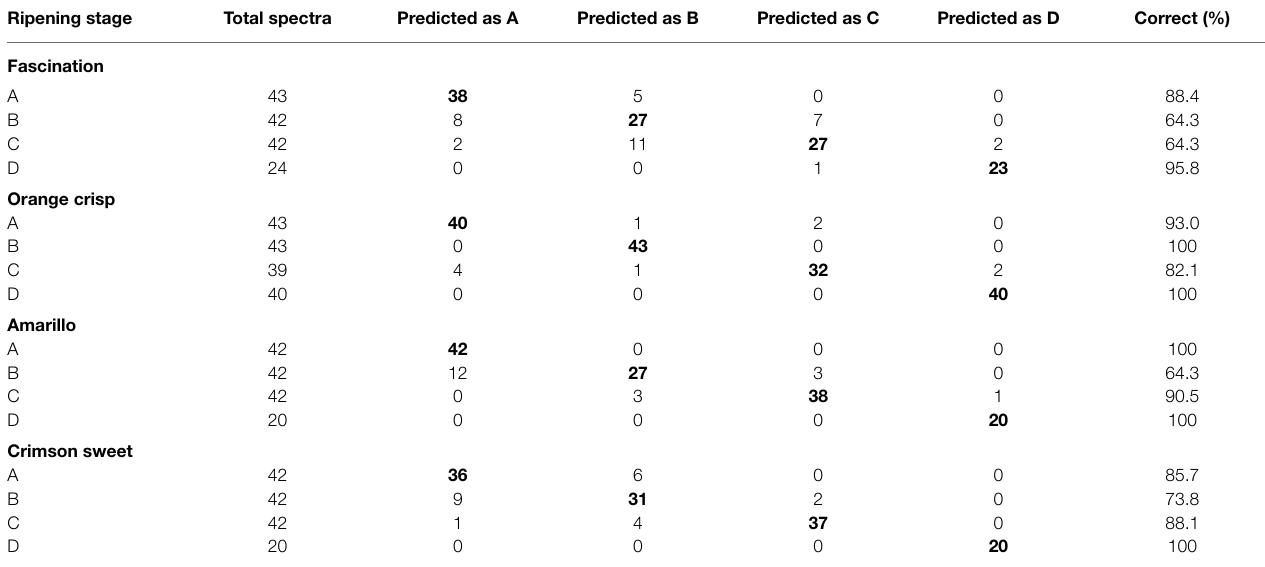
TABLE 1 | Confusion matrix computed from the PLS-DA model of Raman spectra collected from four watermelon cultivars. Ripening